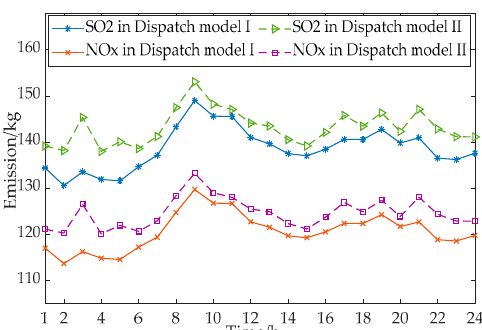
Figure 16. Wind power forecast and accommodation power. 5. Conclusions An economic power dispatch model considering the environmental cost based on CHP-DR is proposed in this paper. The optimized results show that, compared with the traditional dispatch model, the daily average emissions of CO 2 , SO 2 , and NO x are decreased by 14,354.35 kg, 55.5 kg, and 47.15 kg, respectively, and the wind power accommodation is increased by 6.56%. Simulation results demonstrate that the dispatch model is efficient to reduce the emissions of CO 2 , SO 2 , and NO x , and increase the wind power accommodation. The following conclusions can be drawn: (1) The emissions of CO 2 , SO 2 , and NO x could be reduced, and the wind power accommodation could be promoted, when considering the environmental cost in an economic dispatch model; (2) environmental costs can be counted as the cost of power generation, since the environmental cost is closely related to the amount of coal burned; and (3) environmental cost accounts for a certain